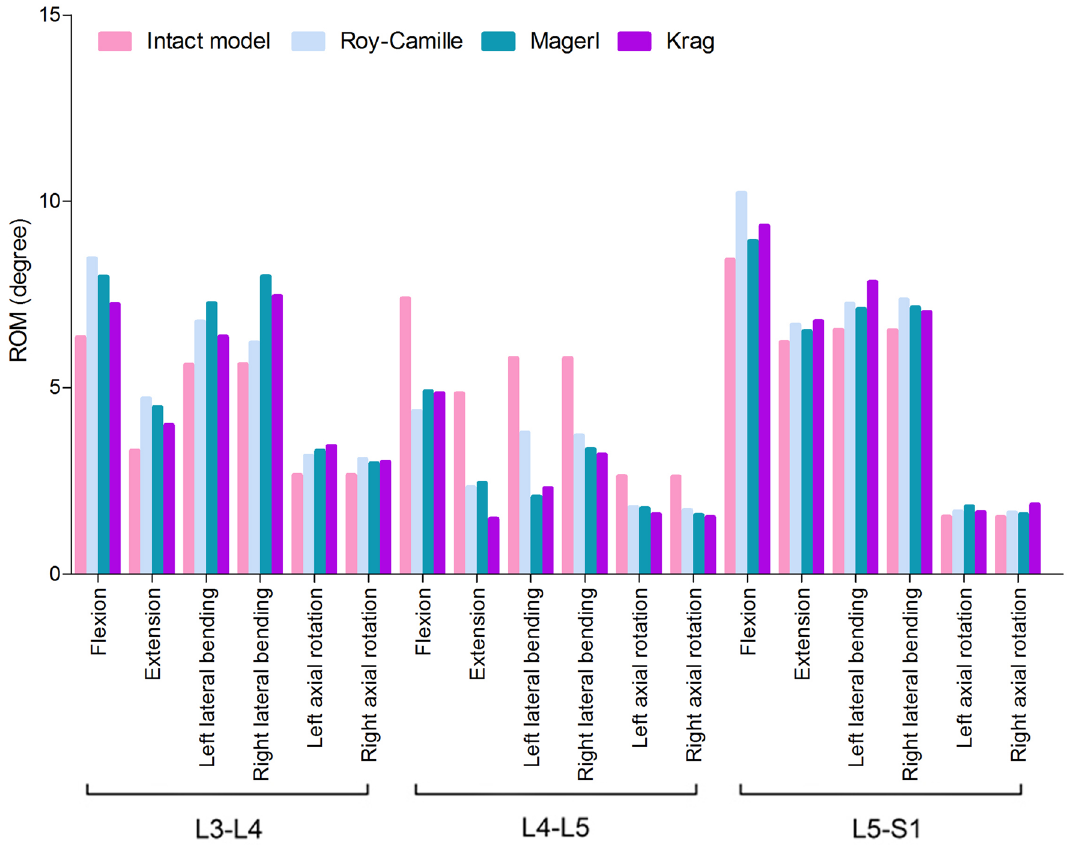
Figure 5. Comparison of ROM, between postoperative FE models and the intact FE